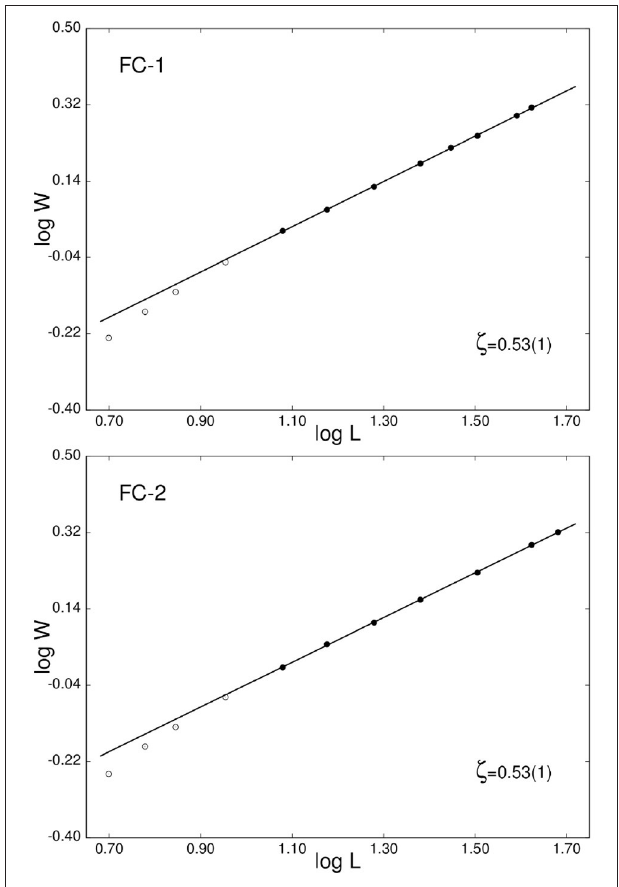
FIGURE 12 | Log-log plots for average roughness, W , as a function of system size, L , for a large number of fractured samples. Disorder magnitude is D = 3. Shown at the top (FC-1) is the result obtained with the “maximum normal stress” criterion, Equation (84). Shown below (FC-2) is the result obtained with the “maximum shear stress” criterion, Equation (77). Black dots indicate those values to which the straight line has been fit using linear